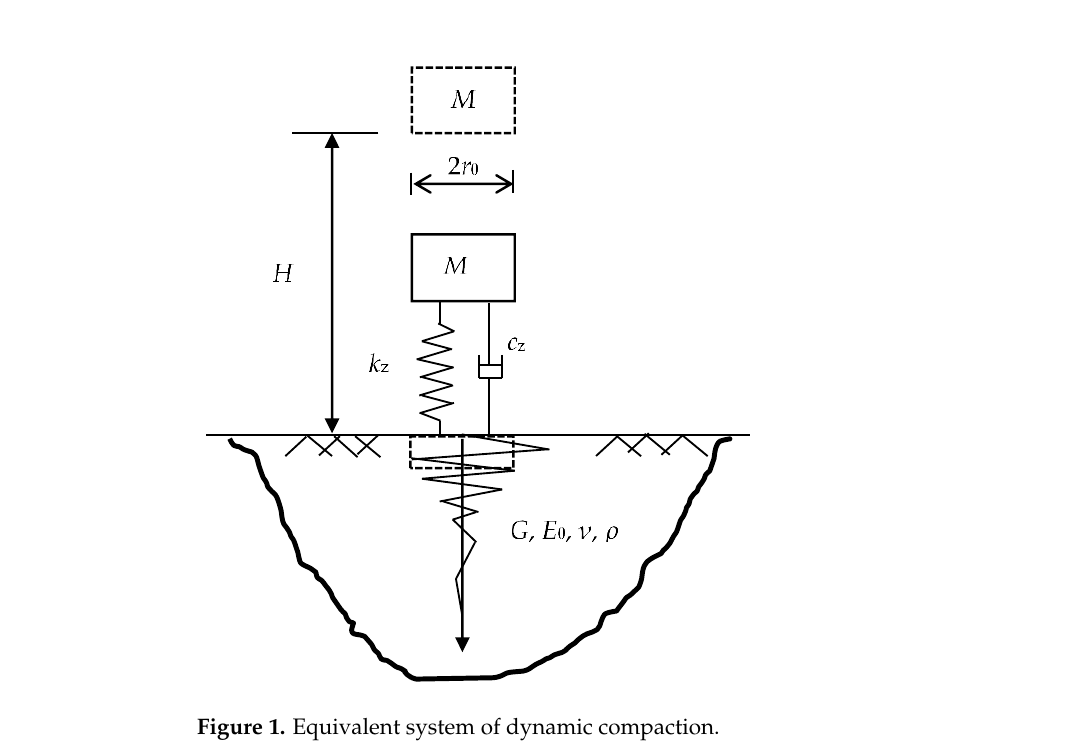
Figure 1. Equivalent system of dynamic compaction.